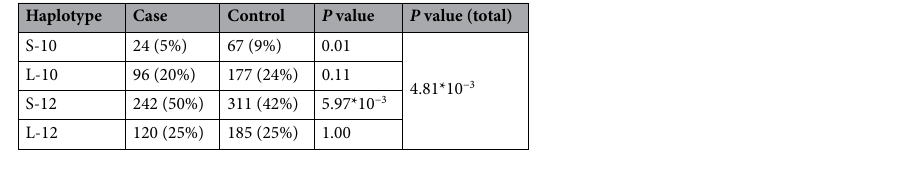
Table 7. Haplotype analysis of S/STin2.12.